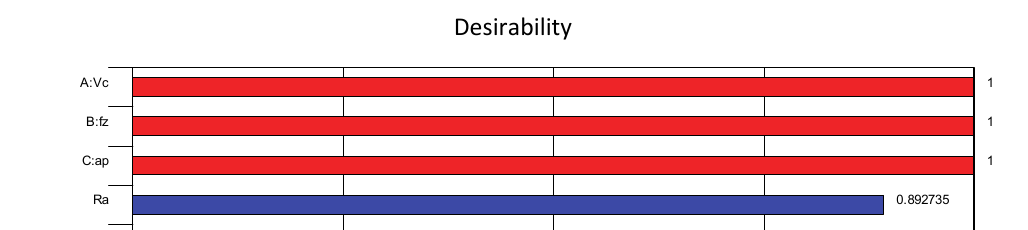
Fig.12 Response surface of Composite desirability for Ra, Ry, Rz and MRR